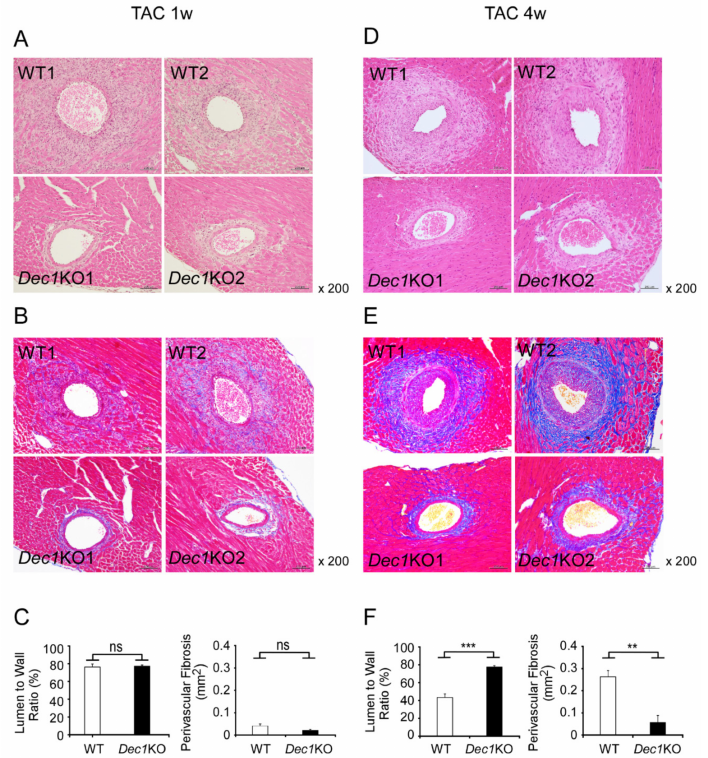
Figure 3. Dec1 deficiency suppresses cardiac perivascular fibrosis induced by TAC. ( A ) Perivascular lesions of WT and Dec1 KO hearts at one week after TAC. Representative images of two independent WT (WT1, WT2) and Dec1 KO ( Dec1 KO1, Dec1 KO2) mice are shown in H&E staining. ( B ) Masson’s trichrome (MT) staining at one week after TAC. Blue color shows fibrosis. ( C ) Quantification of lumen to wall perimeter at one week after TAC in H&E staining (left graph), and perivascular fibrosis area in MT staining (right graph). ( D ) Perivascular lesions of WT and Dec1 KO hearts at four weeks after TAC. ( E ) MT staining at four weeks after TAC. Blue color shows fibrosis. ( F ) Quantification of lumen to wall perimeter and perivascular fibrosis area at four weeks after TAC. Original magnification 200 × ( A , B , D , E ). Data are the means ± SEM of four mice and were analyzed by a two-tailed Student’s t -test. ** p < 0.01 *** p < 0.001; NS: not